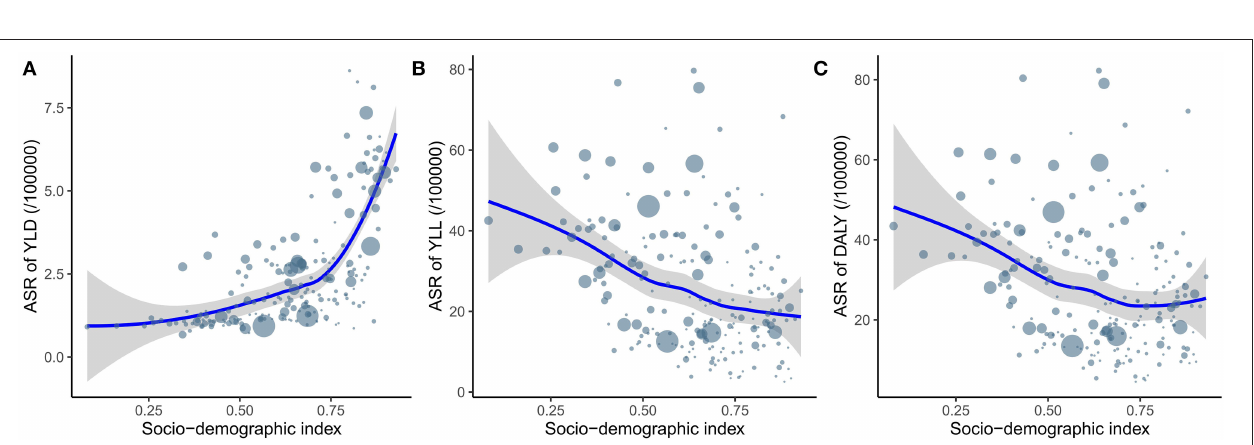
FIGURE 3 | The DALY, YLD, and YLL rate of Down syndrome of different age group. (A) Both sexes; (B) Male and Female (The column above is for male and the column below is for female). DALY, disability-adjusted life year; YLD, year lived with disability; YLL, year of life lost.